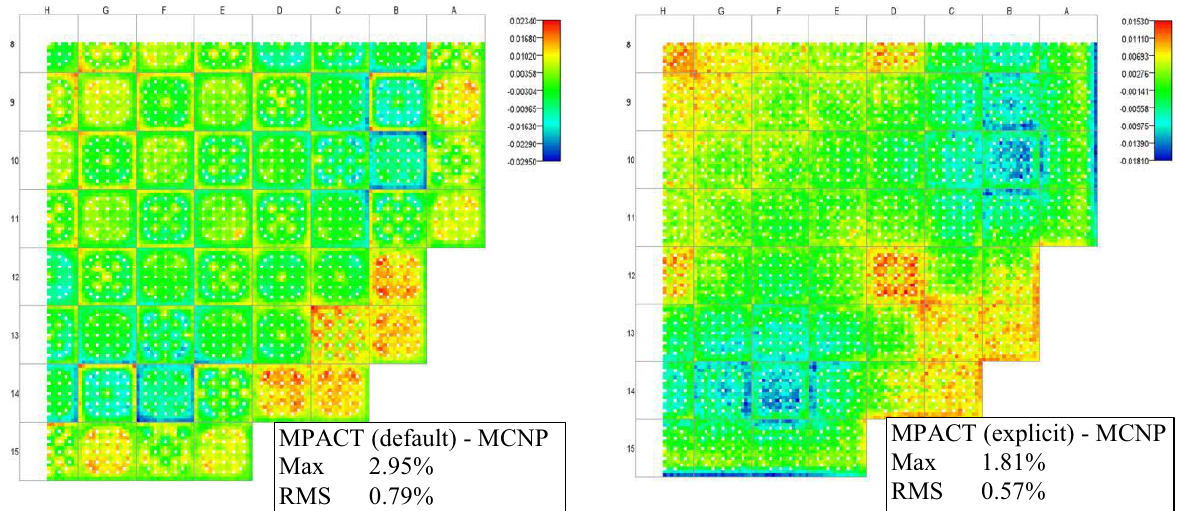
Figure 2. Comparison of energy deposition of fuel pins between MPACT and MCNP for P5-2D. Maximum standard deviation of MCNP results: